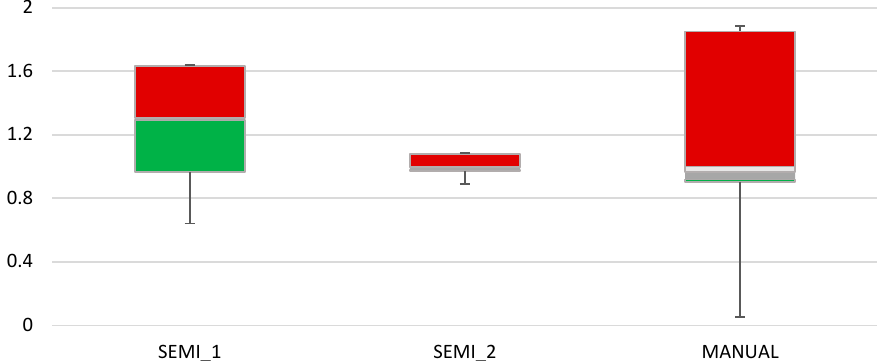
Figure 8. The boxplot of the ICC value reflects the repeatability of radiomic properties across ob- servers. Table 3. Radiomic feature ICC of inter-observer analysis.